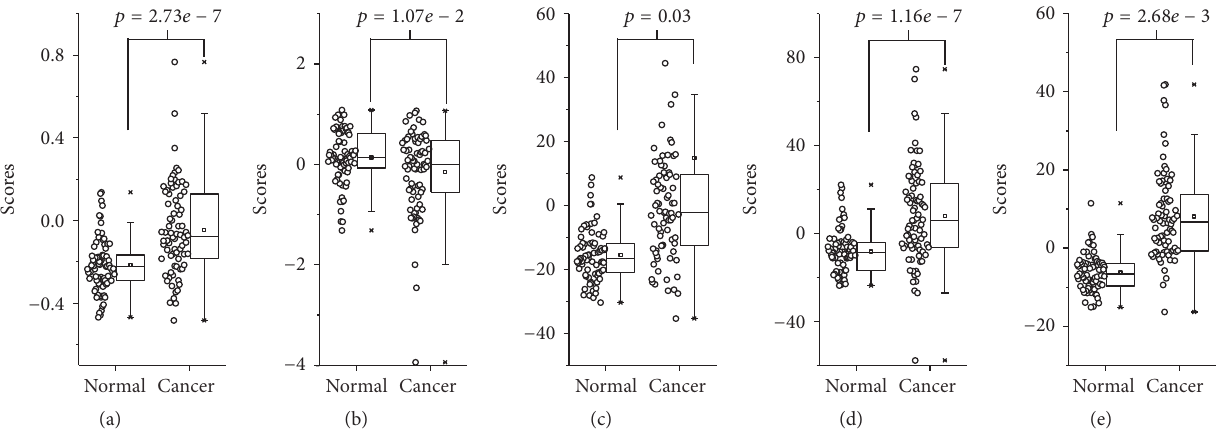
Figure 4: Box charts of the two PCA component (PC) scores and three significant PLS component (LV) scores calculated from the Raman dataset for normal and cancerous tissue types: (a) PC1 score, (b) PC2 score, (c) LV1 score, (d) LV2 score, and (e) LV3 score. The line within each box represents the median, while the lower and upper boundaries of the box indicate the first (25th percentile) and the third (75th percentile) quartiles, respectively. Error bars (whiskers) represent the 1.5-fold interquartile range.